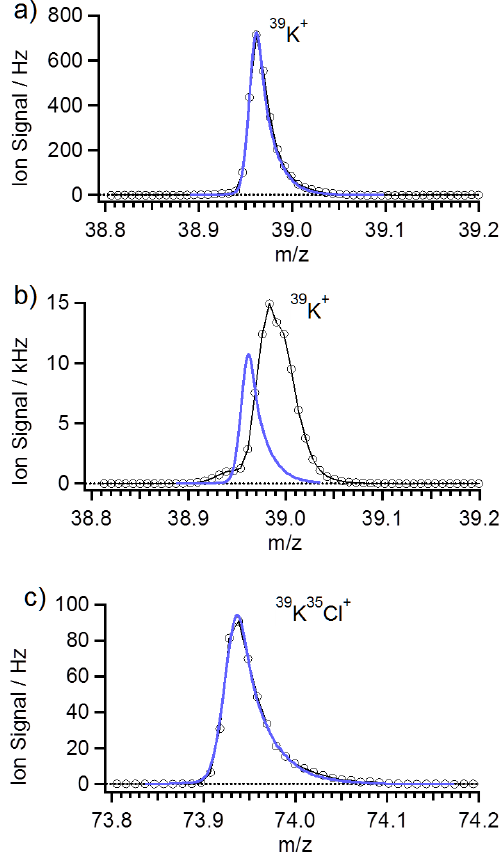
Figure 7. High-resolution mass spectra from the measurement of KCl. Measured data are shown as black markers and traces; blue traces are fits to the data with pre-defined peak positions, shapes and widths according to the expected ion signal. (a) The m/z 39 ( 39 K + ) ion peak at the beginning of the measurement day. (b) The m/z 39 ( 39 K + ) ion peak at the end of the measurement day. (c) The m/z 74 ( 39 K 35 Cl + ) ion peak at the end of the measurement